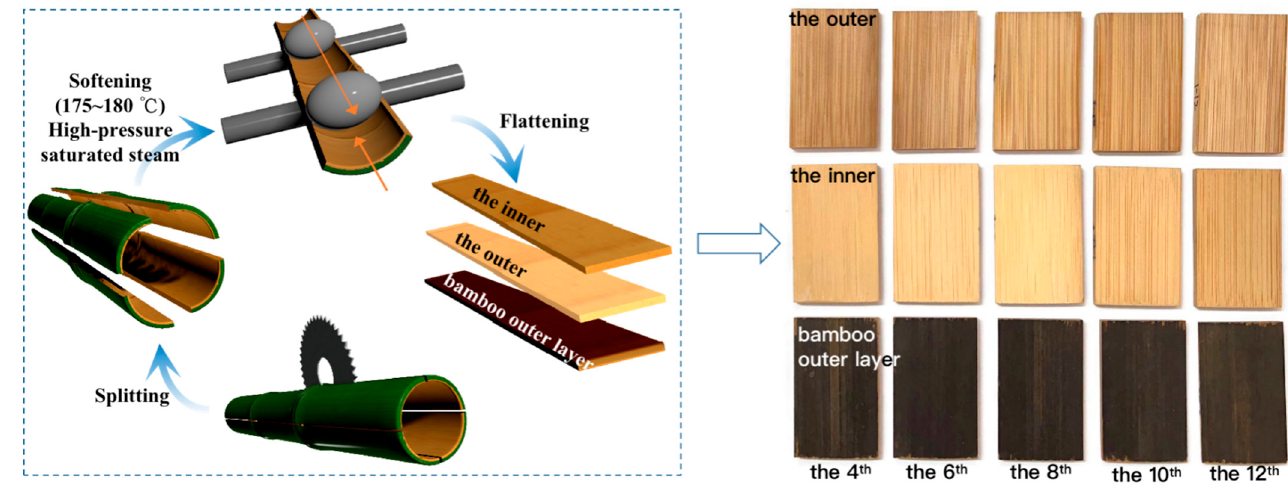
Figure 2. Schematic image of the sample preparation process and flattened bamboo board samples.